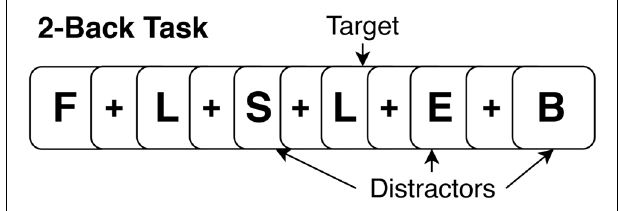
FIGURE 2 | Example of a 2-Back version of